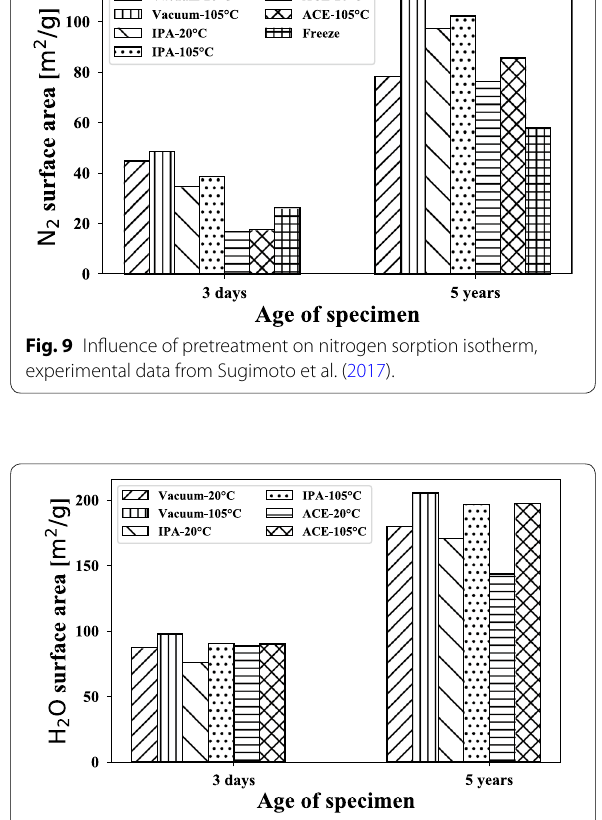
Fig. 10 Influence of pretreatment on water vapor sorption isotherm, experimental data from Sugimoto et al. (2017).